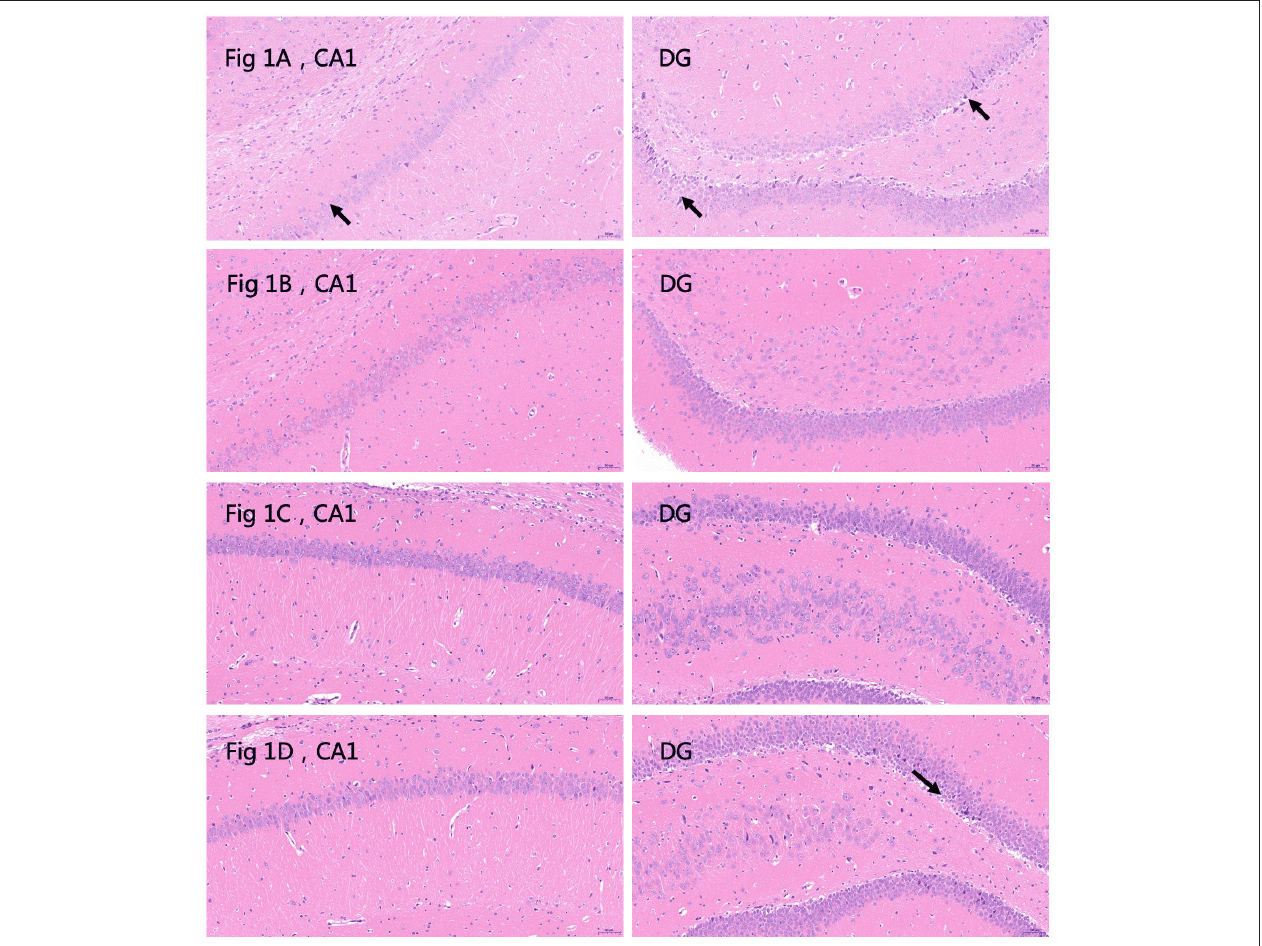
FIGURE 1 | Hematoxylin and eosin (HE) stained sections depicting the CA1 and dentate gyrus (DG) areas of the hippocampus. (A) Plain group, 24h after the last seizure. The arrows indicate deeply stained cells. Neurons are abundant and closely arranged with clear boundaries. A small number of pyramidal cells are deeply stained, and the boundaries between cytoplasm and nucleus are unclear (black arrow). No other obvious abnormalities are observed (20.0 × ). (B) Plain group, 72h after the last seizure. Neurons are abundant and closely arranged, with clear boundaries and normal morphology. The boundaries between cytoplasm and nucleus are clear, and no obvious abnormalities are observed (20.0 × ). (C) Plateau group, 24h after the last seizure. Neurons are abundant and regularly arranged, with normal morphology and structure of neurons, clear boundaries of cytoplasm and nucleus, and no obvious inflammation (20.0 × ). (D) Plateau group 72h after the last seizure. The arrows indicate deeply stained cells. The number of neurons in the hippocampal CA1 region is abundant and regular, the morphology and structure of neurons are normal, and the boundaries of nuclei and cytoplasm are clear. A small number of neurons are wrinkled in the DG region, the cells are deeply stained, and the boundaries of the nuclei and cytoplasm are unclear (black arrow) (20.0 ×